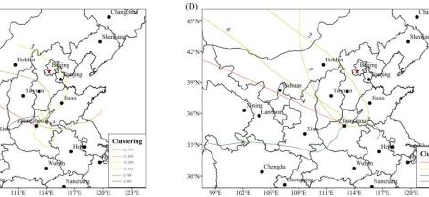
Figure 5 Clustering map of each season in Zhengzhou during